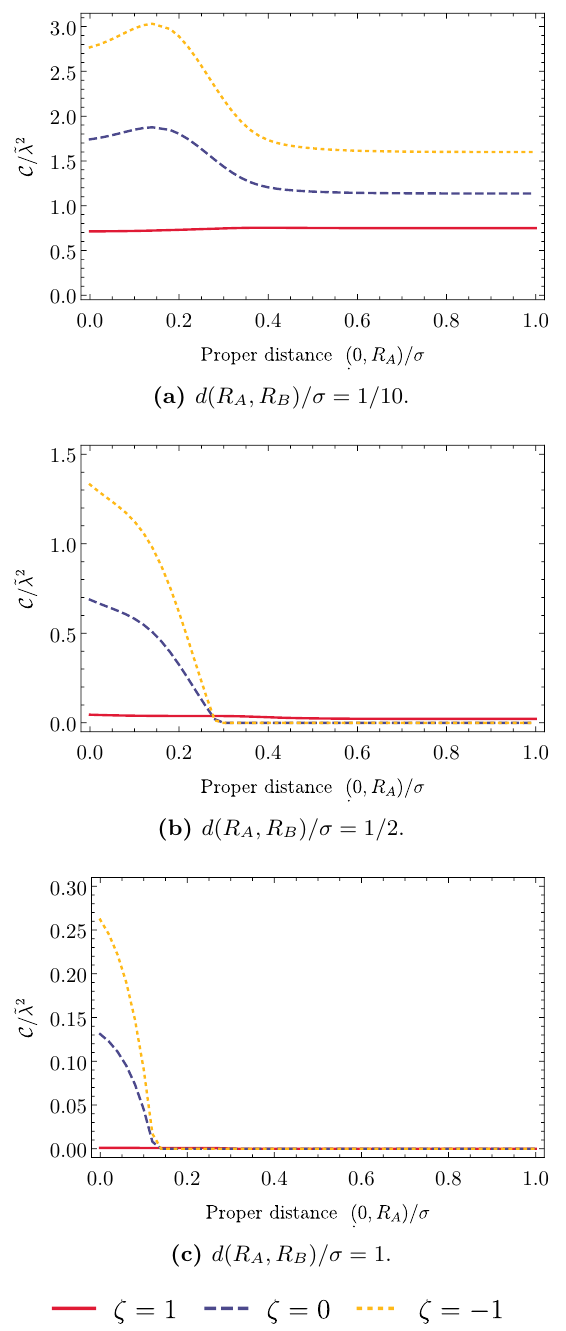
Figure 6 . The concurrence C = ~ (cid:21) 2 associated with the state (cid:26) AB describing two static detectors is plotted as a function of the proper distance d (0 ; R A ) detector A is from the origin, for di(cid:11)erent proper separations d ( R A ; R B ) between the detectors; all boundary conditions (cid:16) = f 1 ; 0 ; (cid:0) 1 g are shown. The AdS length is chosen to be ‘=(cid:27) = 5 and the energy gap of the detectors is (cid:10) (cid:27) = 1 = 100.